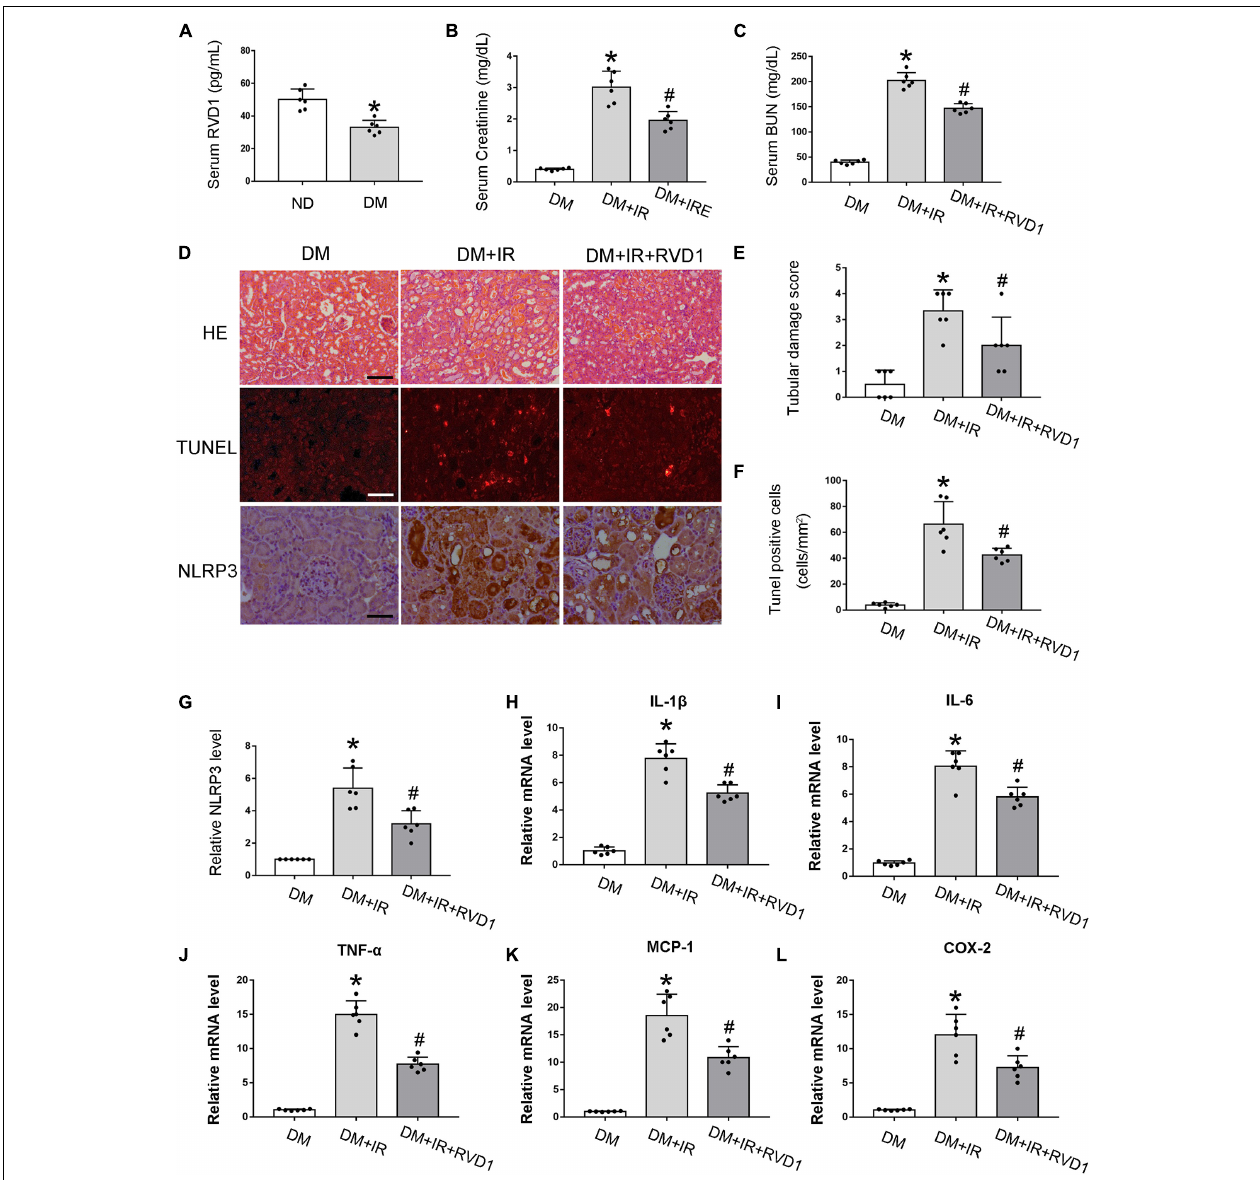
FIGURE 3 | Resolvin D1 (RvD1) attenuated susceptibility to ischemic acute kidney injury (AKI) in diabetes. Male C57BL/6J mice were injected with streptozotocin (STZ) or vehicle solution to induce diabetic mice (DM) or non-diabetic mice (ND). The mice were then subjected to sham operation or 30 min of bilateral renal ischemia followed by 48 h of reperfusion (I/R48). ( A ) Serum RvD1 levels detected by ELISA. All the data are shown as the mean ± SD ( n = 6). * p < 0.05 vs. the relevant ND group. (B,C) Serum creatinine and blood urea nitrogen (BUN). (D) Hematoxylin and eosin (HE) staining for renal tissues. Scale bar , 100 µ m. TUNEL assay to reveal apoptosis of renal tissues: scale bar , 50 µ m. Immunohistochemistry of NLRP3: scale bar, 50 µ m. (E) Semi-quantification for renal tissue damage. (F) Statistical analysis for TUNEL-positive cells. (G) Semi-quantification for NLPR3 expression. (H–L) Real-time PCR for IL-1, IL-6, TNF- α , MCP-1, and COX-2. All the data in (B,C,E–L) are shown as the mean ± SD ( n = 6). * p < 0.05 vs. the relevant DM group; # p < 0.05 vs. the relevant DM + I/R